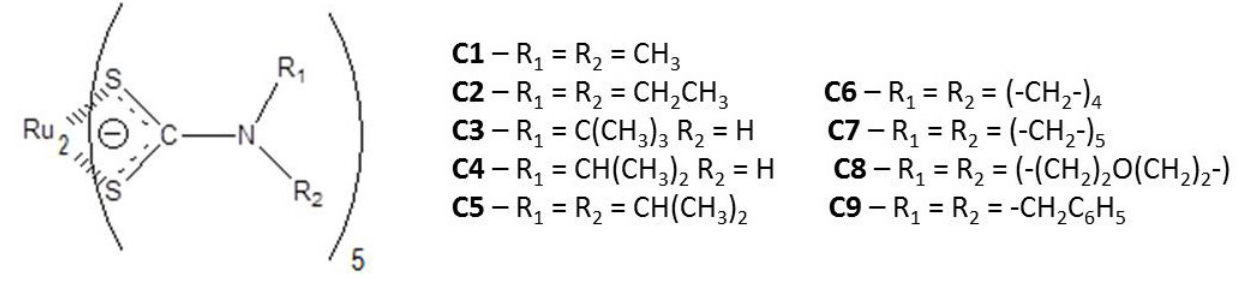
Figure 1. General structure of the studied diruthenium pentakis-dithiocarbamate complexes